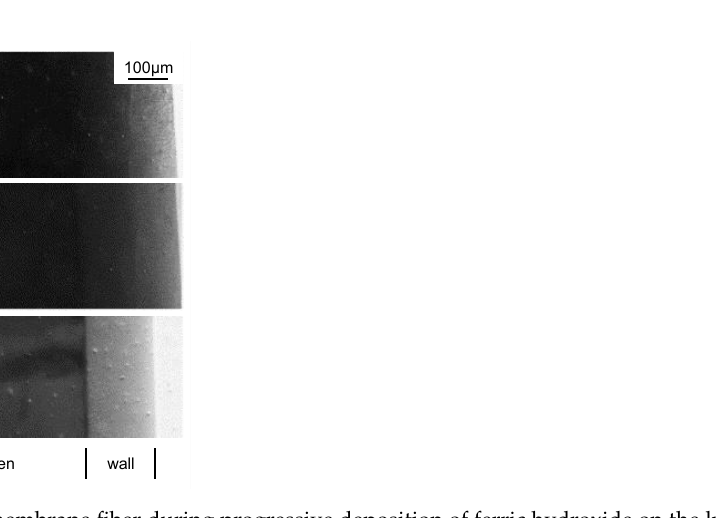
Figure 16. XMI of a membrane fiber during progressive deposition of ferric hydroxide on the lumen wall after ( a ) 0 min, ( b ) 5 min and ( c ) 30 min of operation. The absorptive contrast on the wall gradually increases as the deposition becomes thicker. Adapted from